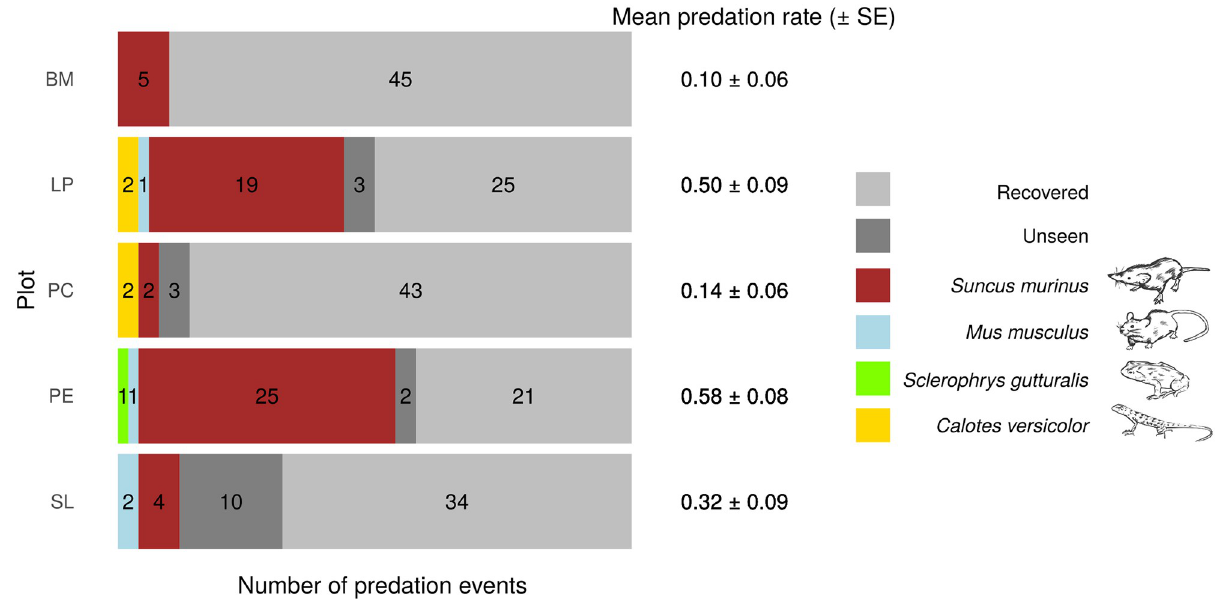
Fig 5. Total number of predation events per plot and per predator specie and the associated mean predation rate (number of predation events/ number of prey deployed). SE is calculated considering each sentinel prey replicate on one plot ( i . e . 25 replicates) .